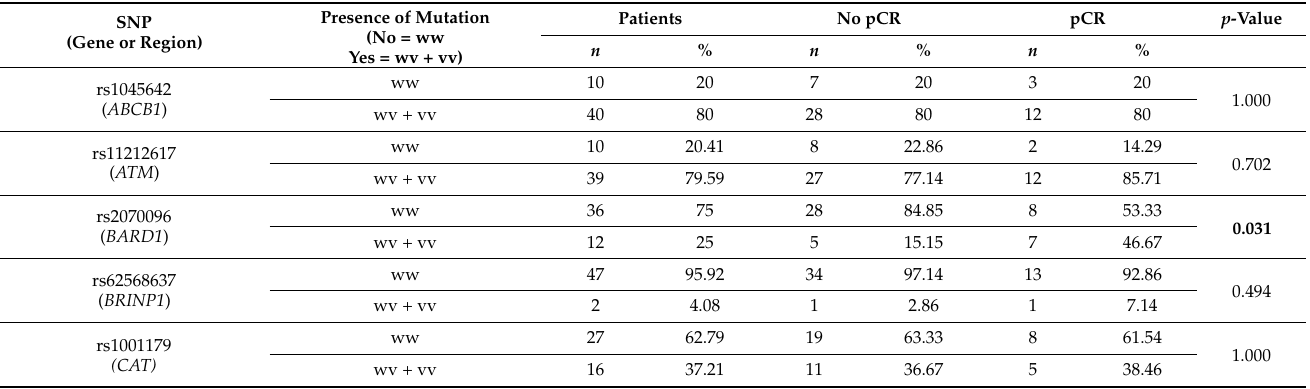
Table 4. Genotype frequencies (presence of mutation or not) in patients showing pCR versus those not showing pCR for 21 SNPs. p -value corresponds to Fisher’s exact test. Significant value is highlighted in bold. w = wild-type allele and v = variant